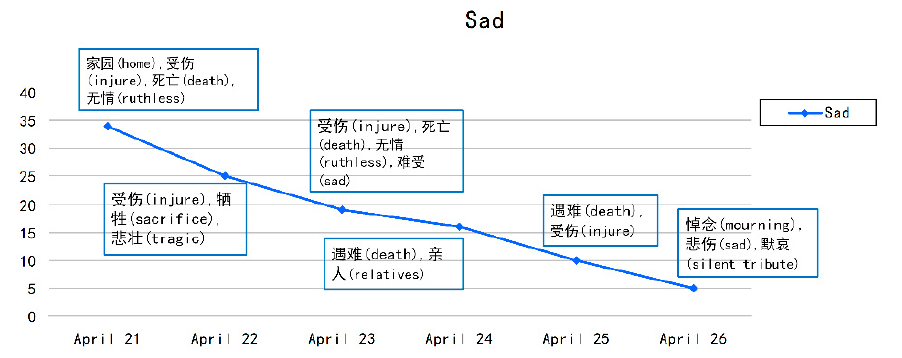
Figure 12. Sequence diagram of sadness.